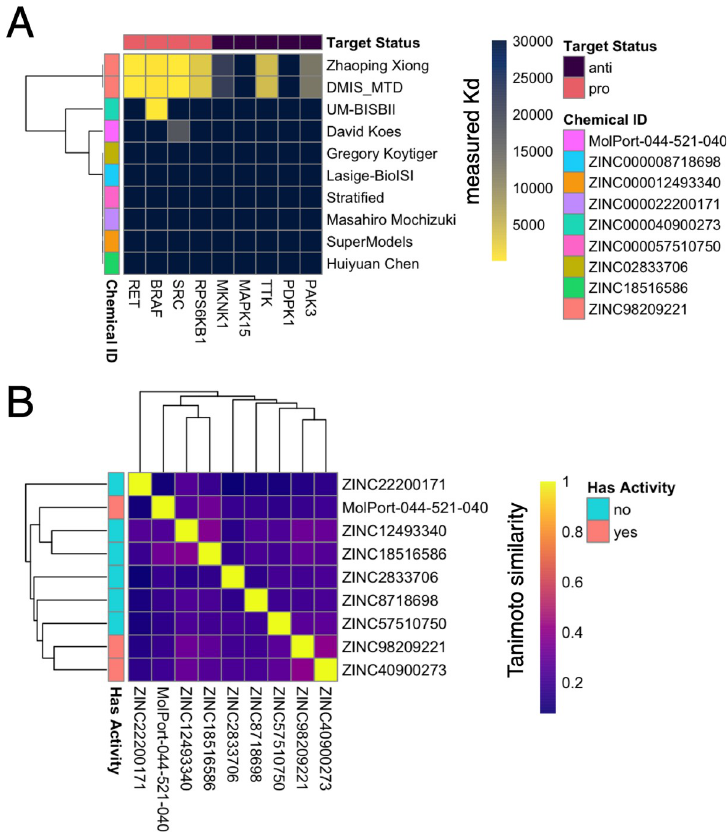
Fig 2. Kd values of experimentally tested candidates from Problem 1. A heatmap indicating the K d s of all compounds tested in Problem 1. The best binder of the pro-targets (ZINC98209221) was predicted by two different